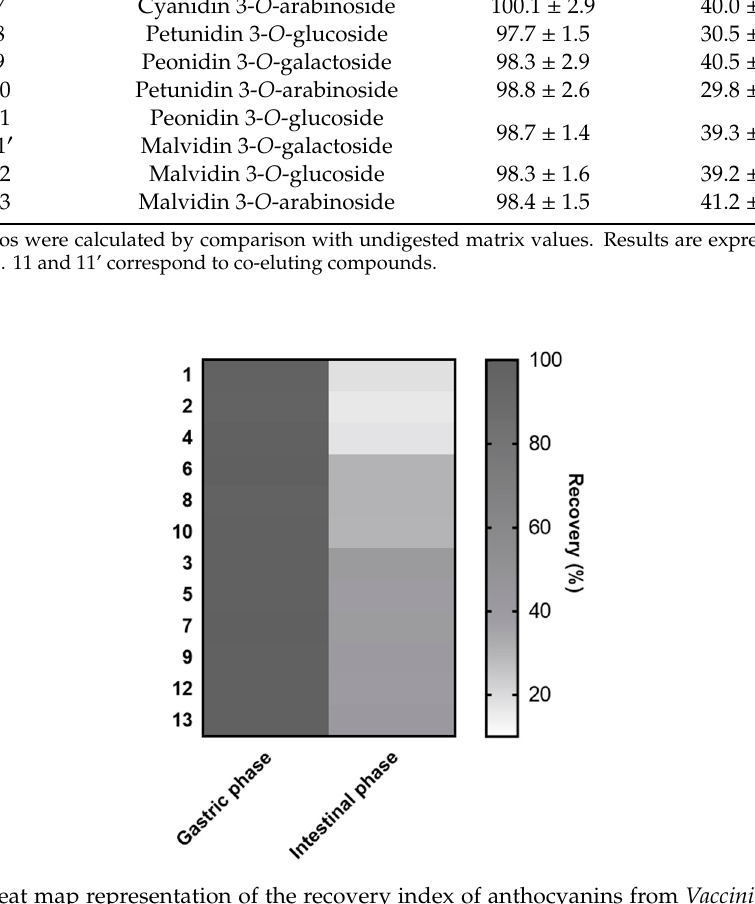
Figure 5. Heat map representation of the recovery index of anthocyanins from Vaccinium myrtillus fruit extract clustered according to their aglycone moieties: delphinidin (1, 2, 4), petunidin (6, 8, 10), cyanidin (3, 5, 7), peonidin (9), and malvidin (12, 13).